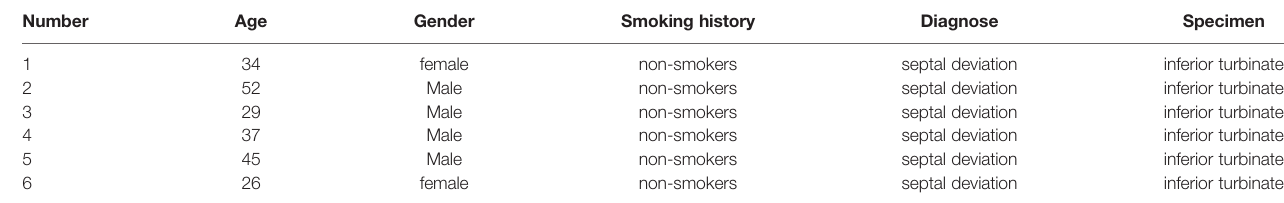
TABLE 1 | The characteristics of donating